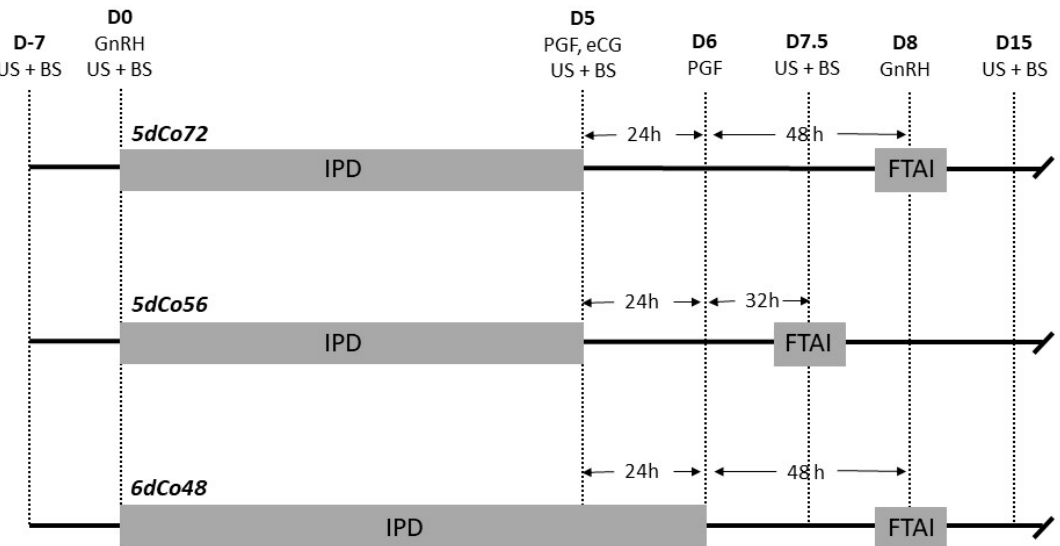
Figure 1. Illustration of treatments and activities during experiment 1: 5dCo72 = 5d Co-synch 72-h protocol with intravaginal progesterone device (IPD); 5dCo56 = 5d Co-synch 56-h protocol with IPD; 6dCo48 = 6-d Co-synch 48-h with IPD; FTAI = Fixed Time Artificial Insemination; D = Day of the study; US = ultrasonography; BS = blood sampling; GnRH = gonadorelin; IPD = intravaginal progesterone device; PGF = prostaglandin; eCG = equine chorionic gonadotropin.